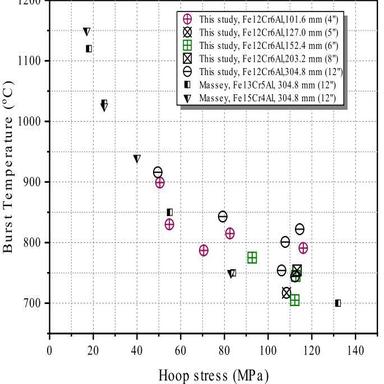
Burst temperature as a function of hoop stress. Data represented by halffilled symbols were obtained in. For better resolution please see the web version of the paper.3